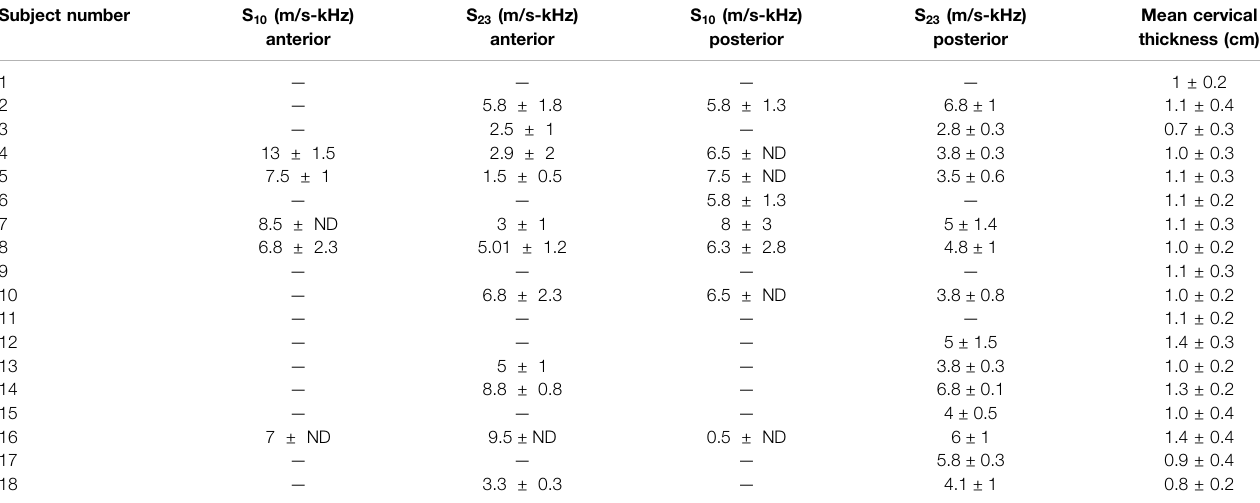
TABLE 3 | S values of each macaque calculated in the anterior and posterior region with respect to the cervical canal during gestation weeks 10 and 23. Cervical mean thickens is also showed for each macaque. Subject number Mean cervical